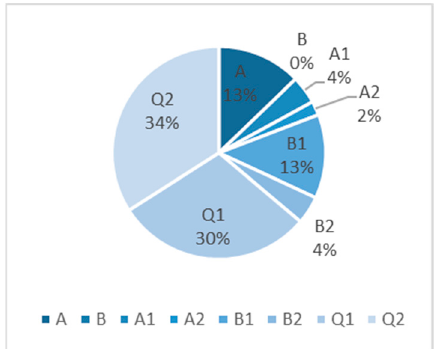
Figure 3. Articles Percentage by Publication